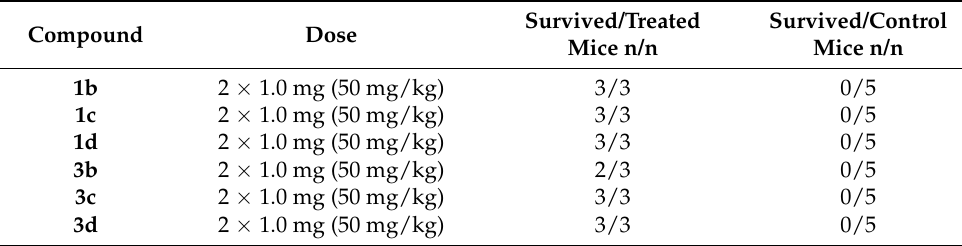
Table 5. Effectiveness of in vitro active products in the “ Staphylococcus -infected, immune suppressed mouse” model– Staphylococcus aureus ATCC